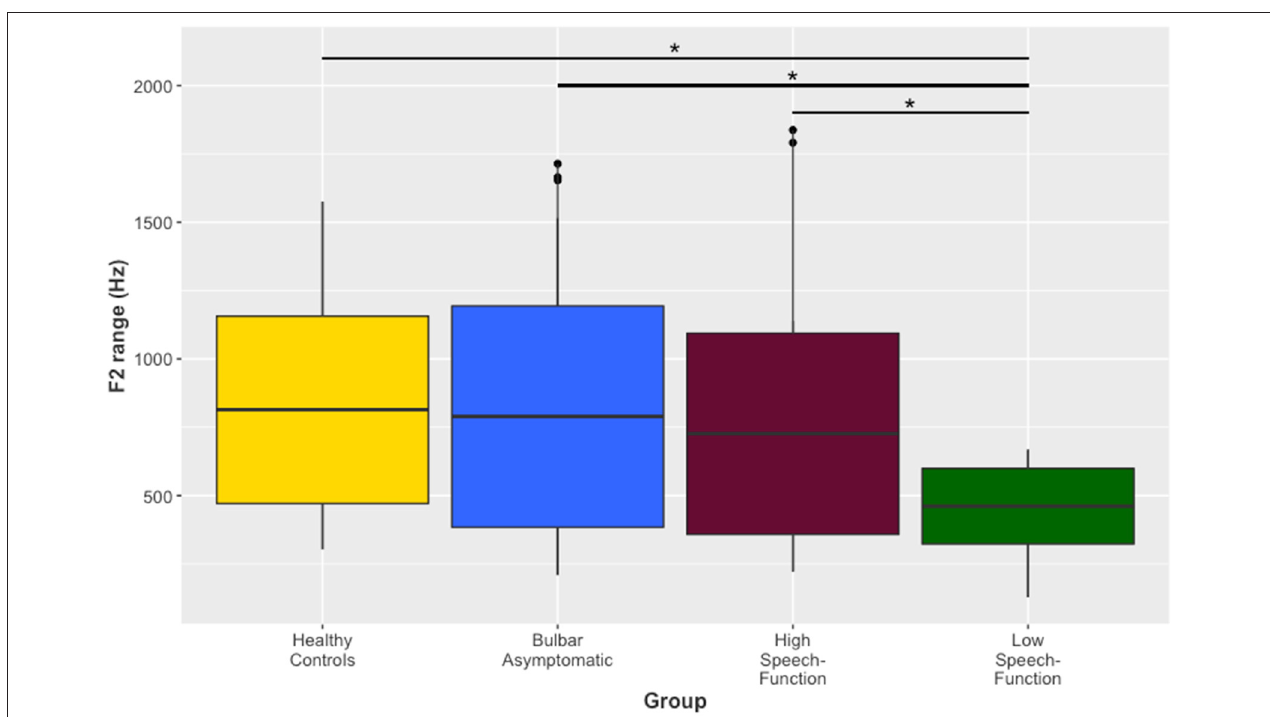
FIGURE 2 | Range of the second formant (F2). Range of F2 (Hz) in the segment “flower” from the passage reading task across the four groups. Healthy controls, the bulbar asymptomatic group, and the high speech-function group did not differ from each other, but the low speech-function group had a significantly smaller F2 range than the three other groups. [* p < 0.05]. F2, second formant; Hz,